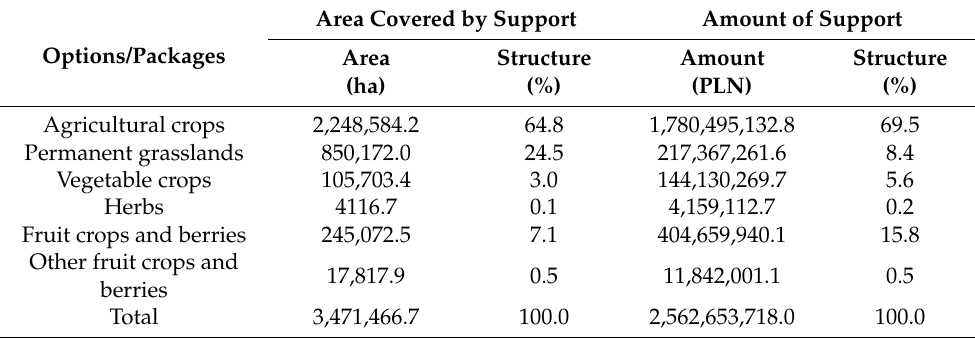
Table 4. Area under and support allocated to organic farming by option provided for in the 2007–2013